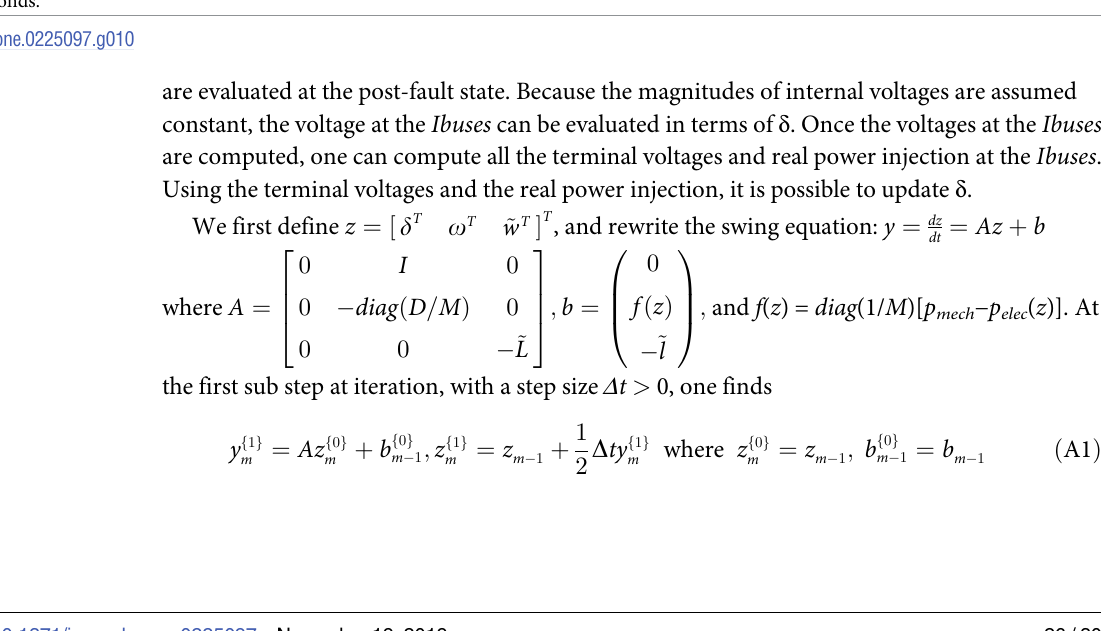
( t ), and (D) the estimated magnitudes of internal voltages after i